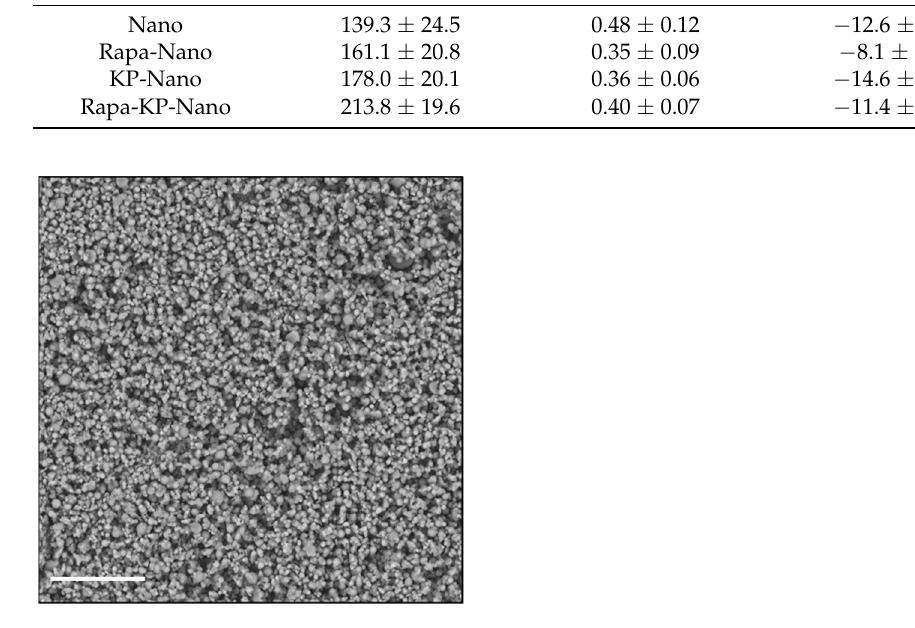
Figure 2. SEM image of microparticles made by mannitol (Man) and Rapa-loaded KP-Nano, obtained by SD. The bar represents 20 μ m.